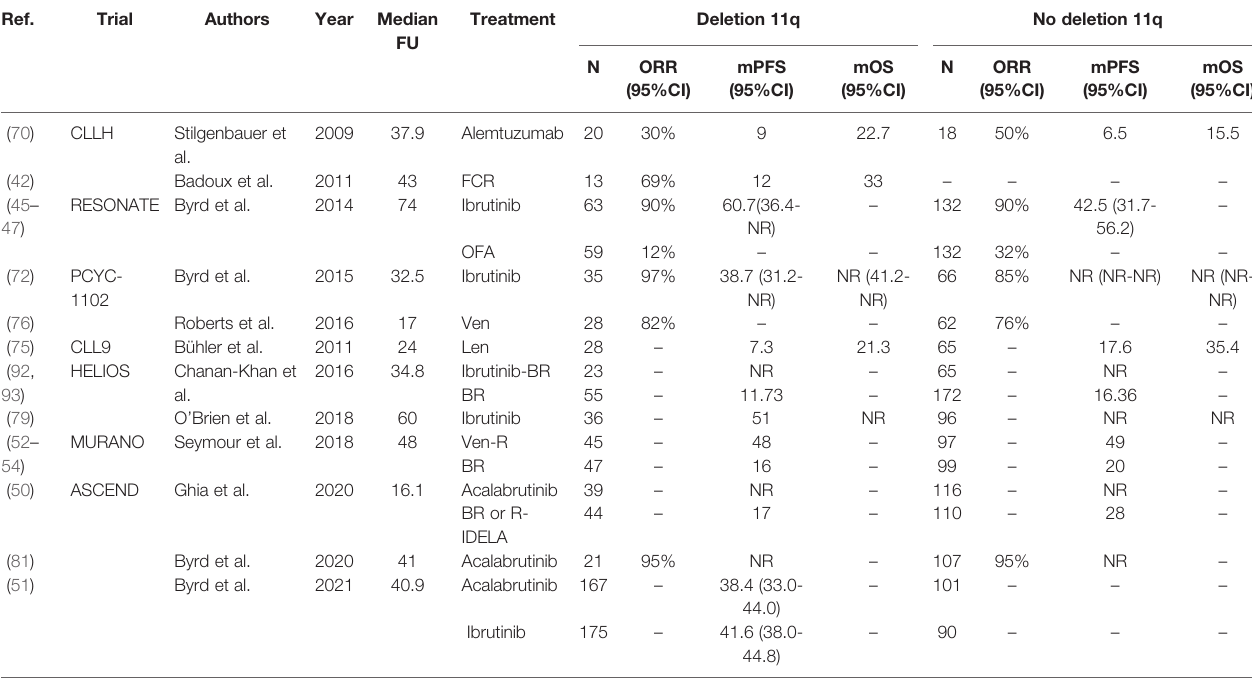
TABLE 4 | An overview of clinical trials comparing treatment regimens for relapsed or refractory CLL patients with deletion 11q. Ref.